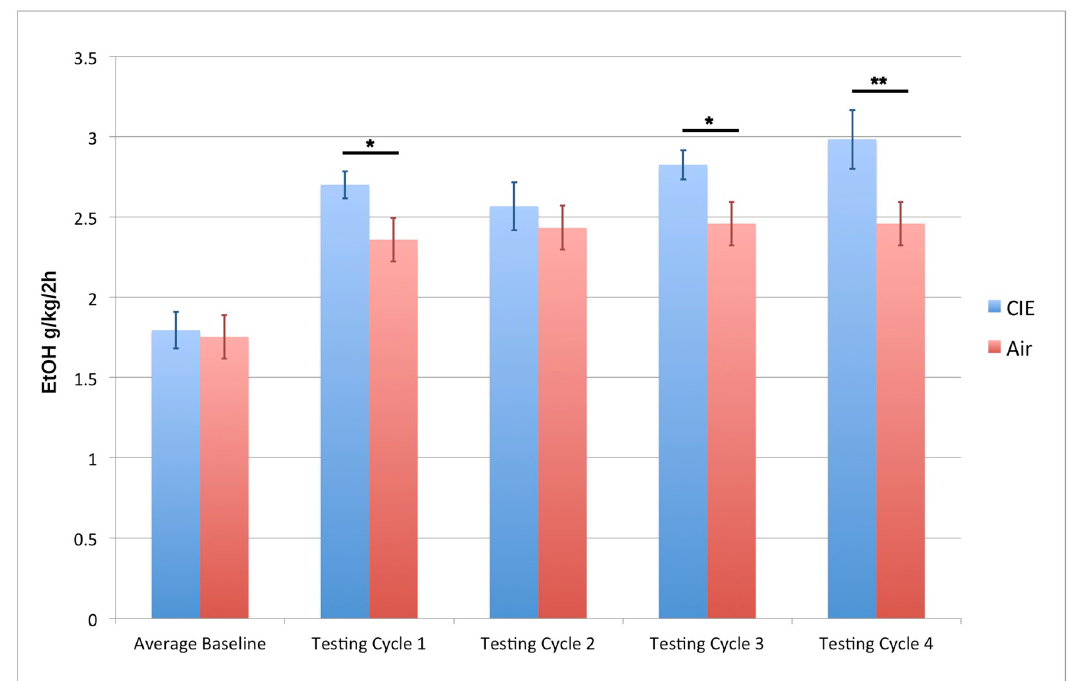
Fig 2. Ethanol intake in CIE and air control mice. Statistical difference in ethanol intake measured by two-way ANOVA with repeated measures, � p-value � 0.05, �� p-value � 0.01.